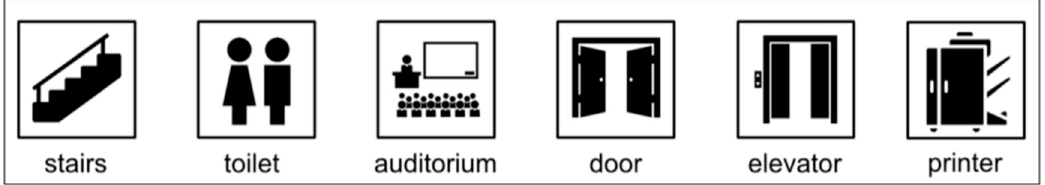
Figure 15. Pictogram-based landmarks.